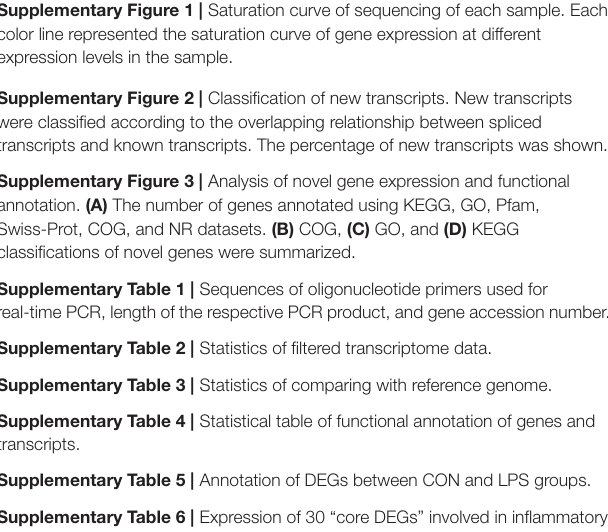
Supplementary Figure 1 | Saturation curve of sequencing of each sample. Each color line represented the saturation curve of gene expression at different expression levels in the sample. Supplementary Figure 2 | Classification of new transcripts. New transcripts were classified according to the overlapping relationship between spliced transcripts and known transcripts. The percentage of new transcripts was shown. Supplementary Figure 3 | Analysis of novel gene expression and functional annotation. (A) The number of genes annotated using KEGG, GO, Pfam, Swiss-Prot, COG, and NR datasets. (B) COG, (C) GO, and (D) KEGG classifications of novel genes were summarized. Supplementary Table 1 | Sequences of oligonucleotide primers used for real-time PCR, length of the respective PCR product, and gene accession number. Supplementary Table 2 | Statistics of filtered transcriptome data. Supplementary Table 3 | Statistics of comparing with reference genome. Supplementary Table 4 | Statistical table of functional annotation of genes and transcripts. Supplementary Table 5 | Annotation of DEGs between CON and LPS groups. Supplementary Table 6 | Expression of 30 “core DEGs” involved in inflammatory signaling